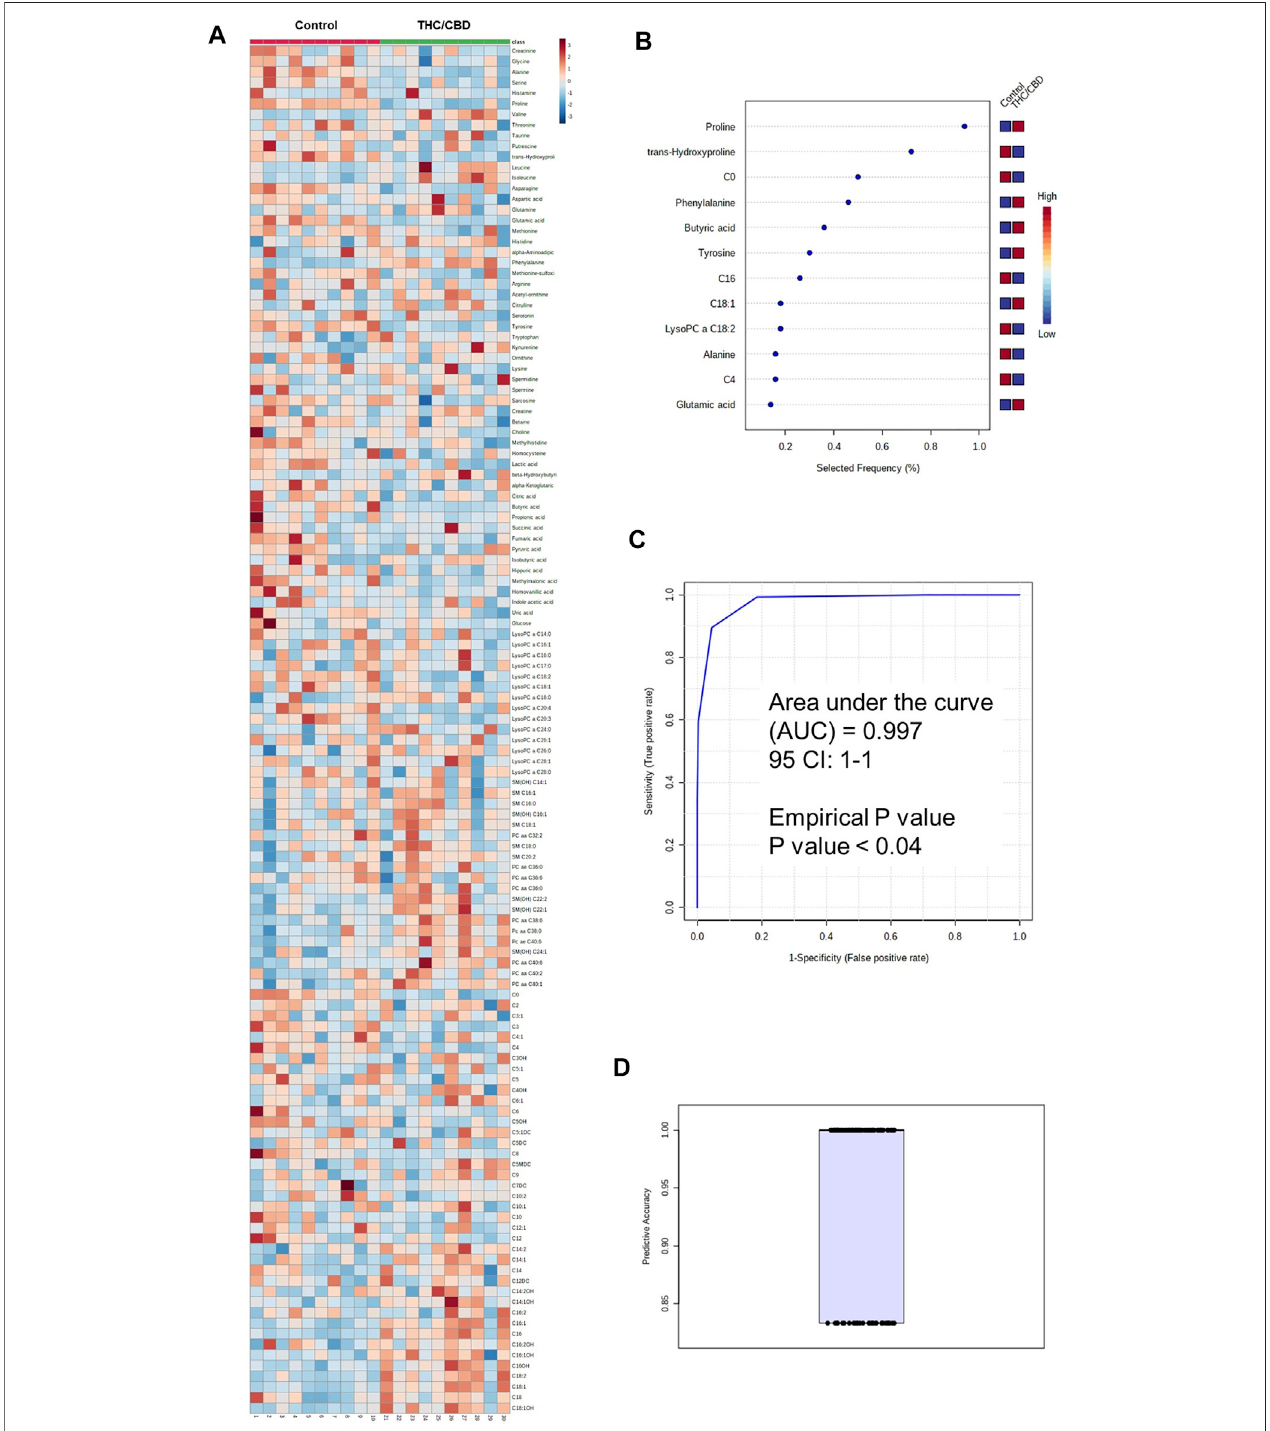
FIGURE 2 | Metabolomic differences between full-spectrum cannabis extract and controls. (A) Heat map of metabolomic differences between full-spectrum cannabis extract and controls. Heat maps were generated with the concentrations of potential candidate metabolites with univariate analysis. Similar metabolites were arranged together for use in pathway analysis through intuitive pattern discovery. The heat map displays an increase in each metabolite in relative concentration as red colorand adecrease inametaboliteasbluecolor.Themetabolitesarelistedat theleftsideofeachrow, and thesubjectsareshown atthebottom ofeachcolumn. (B) Rank of the different metabolites (the top 12) identi fi ed by the PLS-DA according to the selected frequency on the x -axis. The most discriminating metabolites are shown indescending orderoftheirscores.Thecolorboxesindicate whethermetaboliteconcentrationhasincreased(red)ordecreased(blue)invehicle-treated andfull- spectrum cannabis extract – treated rats. (C) ROC curve of the metabolite model. (D) Predictive accuracy of the metabolite model in vehicle-treated and full-spectrum cannabis extract – treated rats. The fi gures were drawn via MetaboAnalyst software v 4.0 (https://www.metaboanalyst.ca).